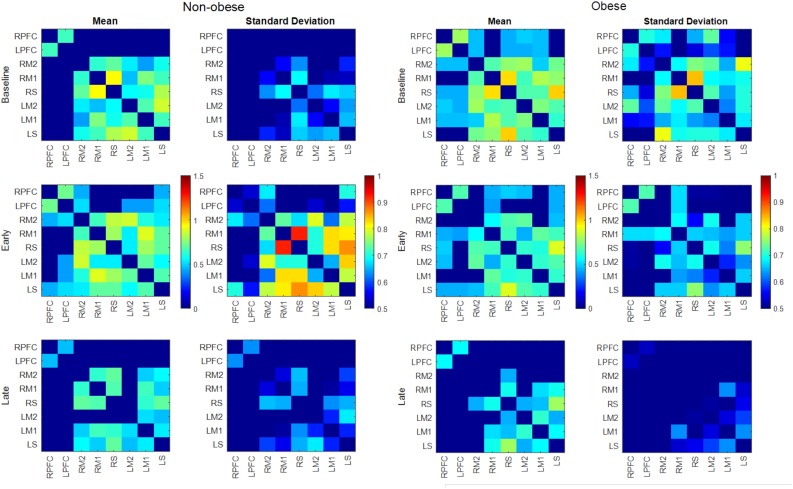
Mean and SD of connectivity matrix for each phase in the non-obese (Left) and obese (Right) groups. Color matrices are produced out of Fischer’s Z-score.